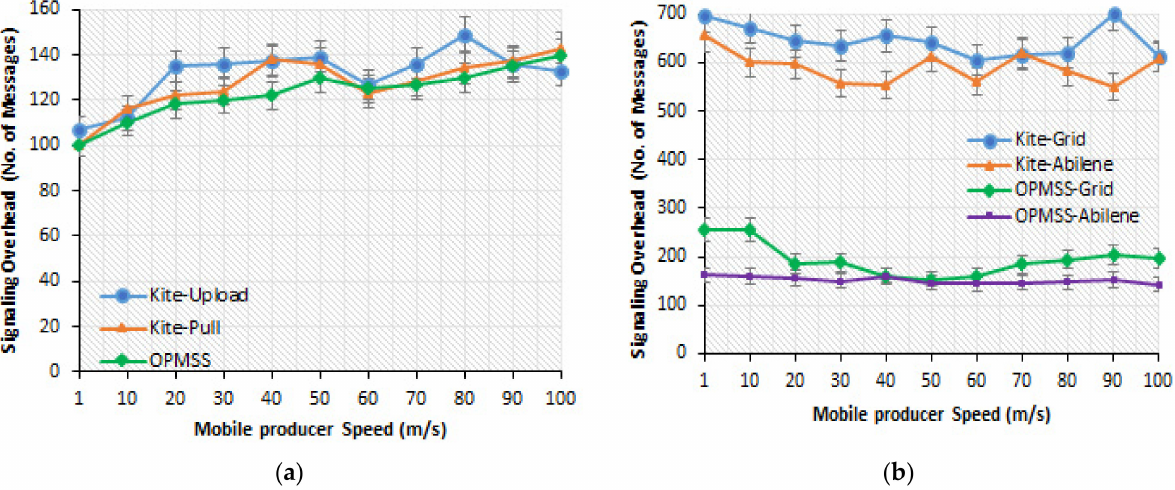
Figure 8. ( a ) Signaling overhead vs. speed in the grid scenario, ( b ) Average packet delay vs.